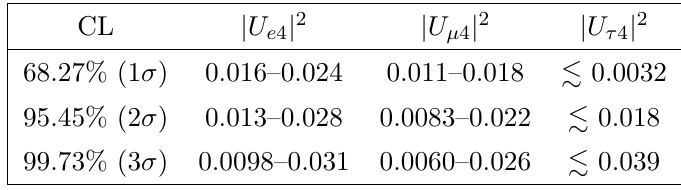
Table 6 . Marginal allowed intervals of the mixing parameters j U e 4 j 2 , j U (cid:22) 4 j 2 , and j U (cid:28) 4 j 2 obtained in the pragmatic 3+1 global (cid:12)t \PrGlo17" of SBL data. the regions allowed by the (cid:12)ts of appearance and disappearance data, the PrGlo17 (cid:12)t has a minimum (cid:31) 2 signi(cid:12)cantly smaller than the Glo17 (cid:12)t, which leads to an increased